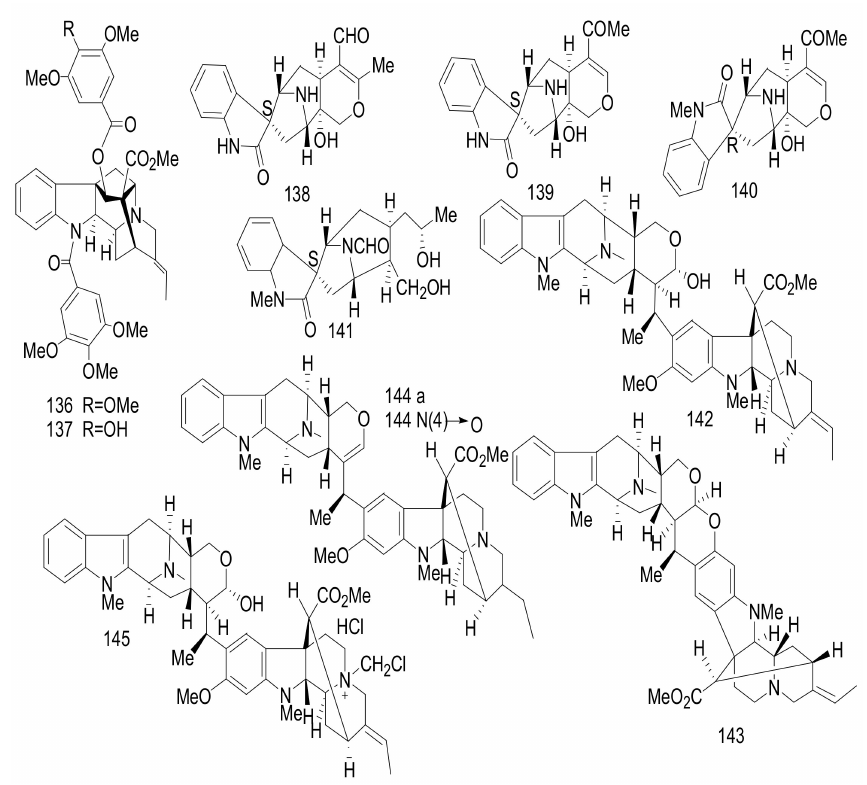
Figure 16. Compounds 136 – 145 .